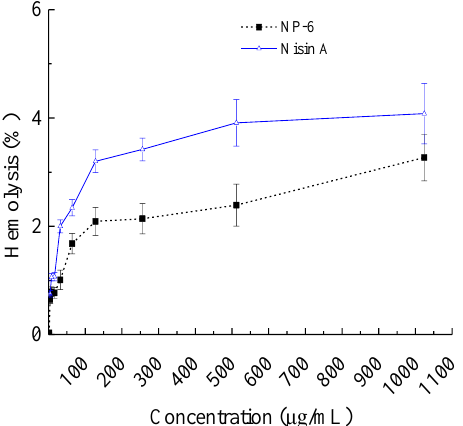
Figure 1. Hemolysis activity of NP-6. The values represent the means ± SD ( n =